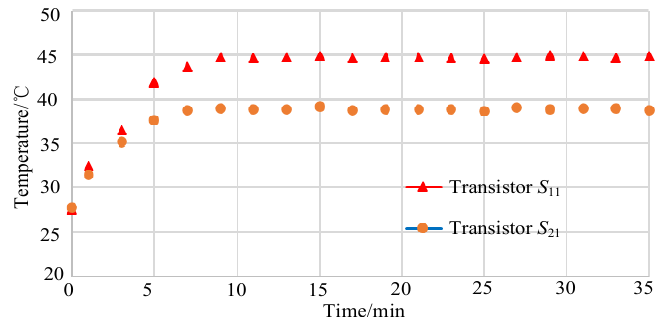
Figure 17. Temperature rising of transistors S 11 and S 21 in the proposed CSR system.